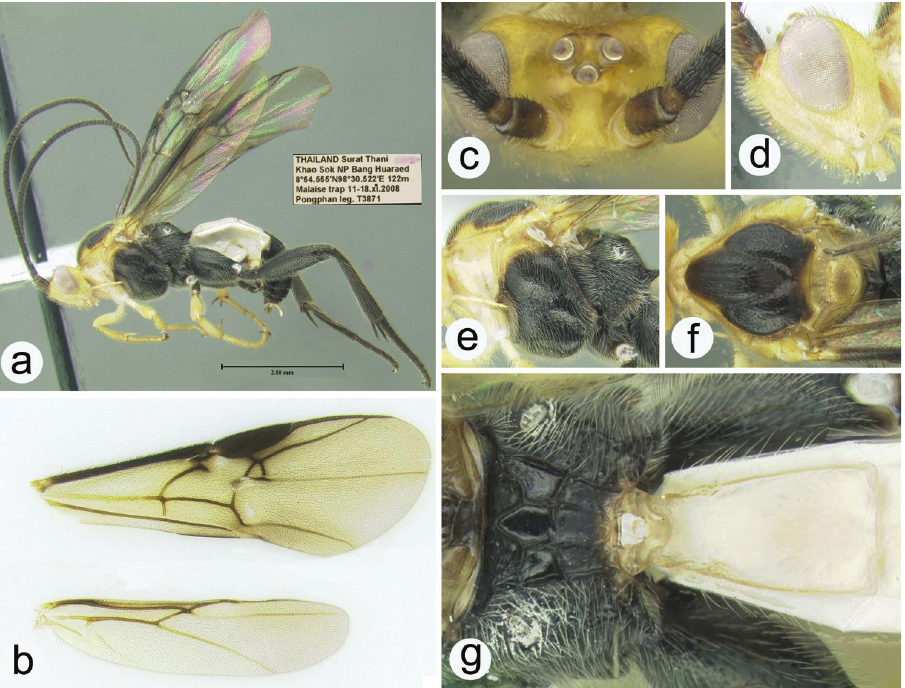
Figure 13. Zelodia poonsathiti sp.n. a lateral habitus b wings c dorsal head d lateral head e lateral meso- soma f dorsal mesosoma g dorsal propodeum and